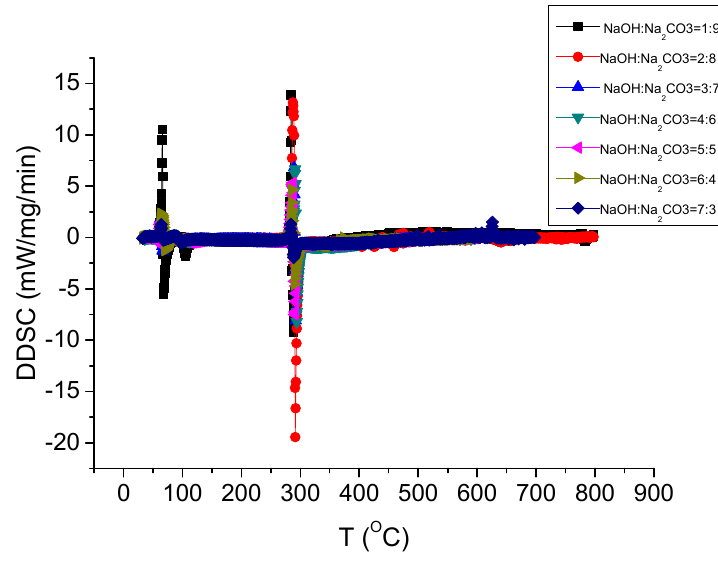
Figure 10. Melting point of a molten salts mixture with di ff erent NaOH:Na 2 CO 3 molar